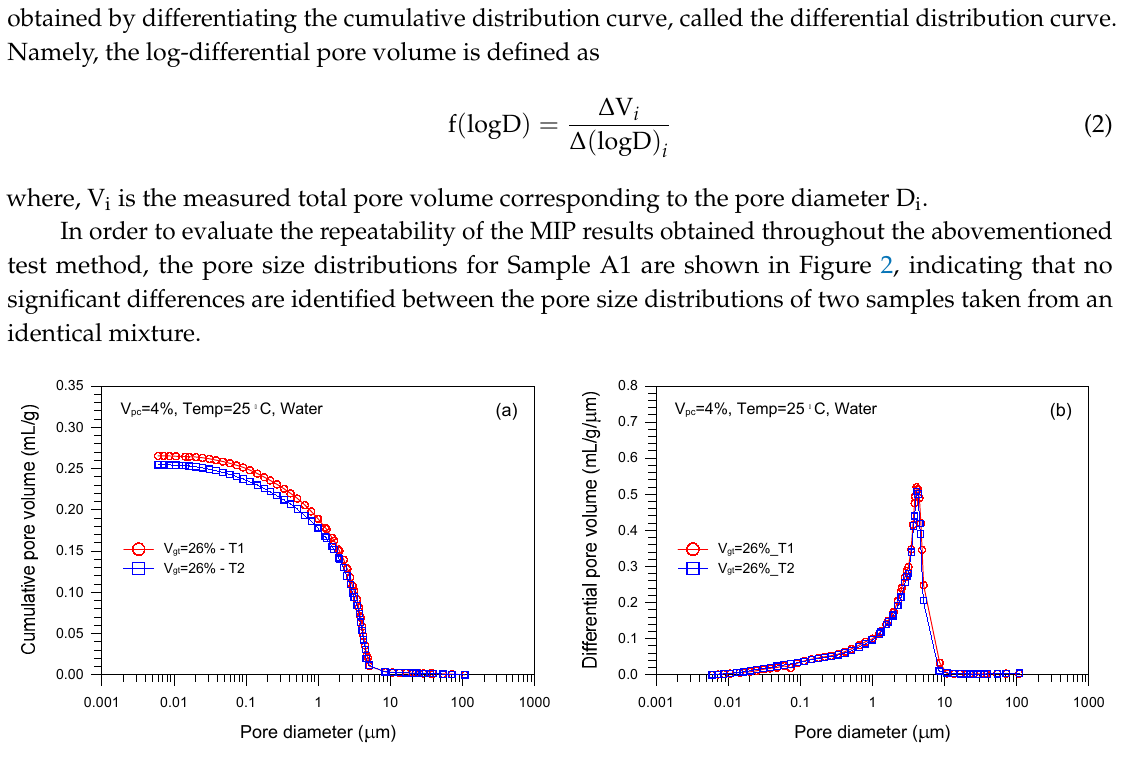
Table 2. Summary of mix proportion and total pore volume